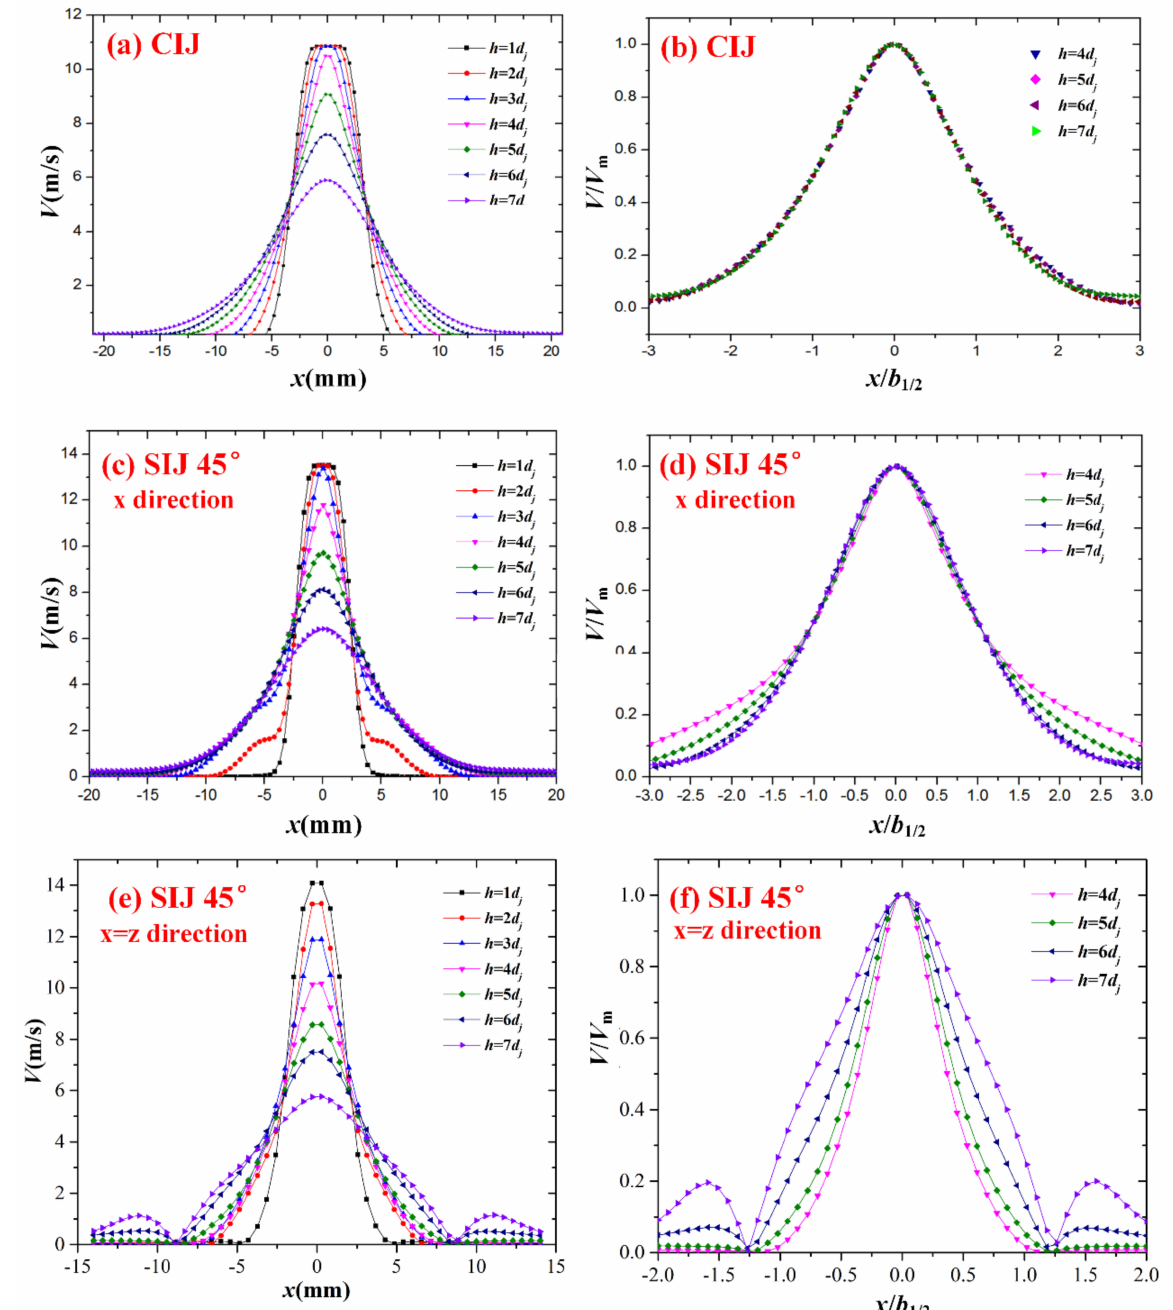
Figure 6. Velocity distribution of different sections: ( a ) CIJ, ( b ) dimensionless data of CIJ, ( c ) SIJ 45 ◦ , ( d ) dimensionless data of SIJ 45 ◦ along the x -direction, ( e ) SIJ 45 ◦ , and ( f ) dimensionless data of SIJ 45 ◦ along the x = z